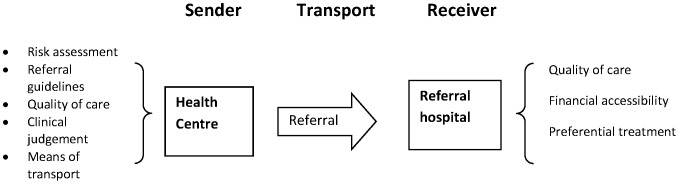
Model of referral chain, adapted from Jahn A and De Brouwer V 2001.